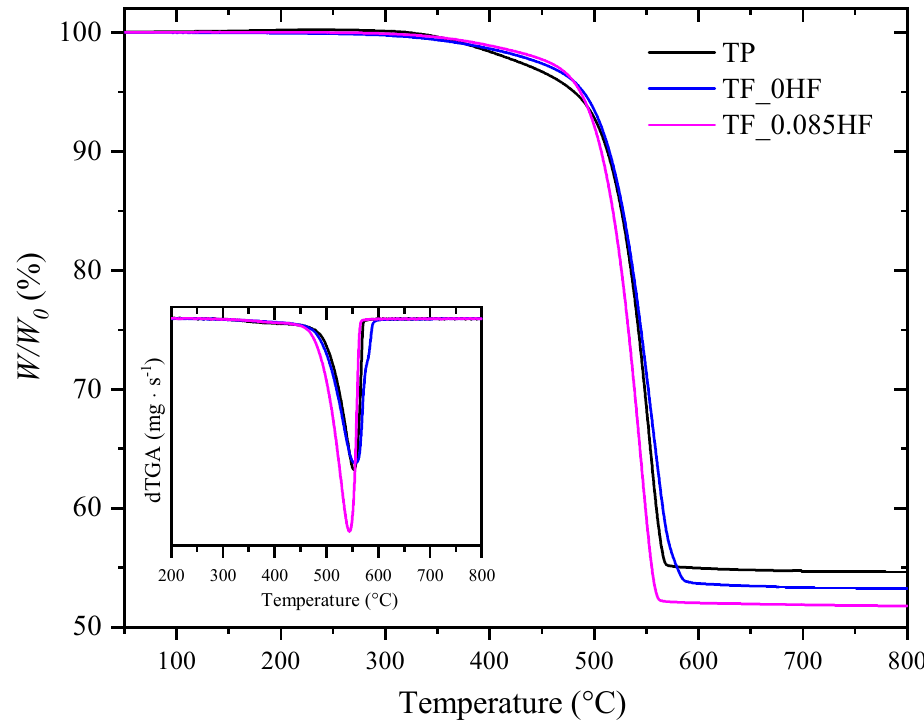
Figure 4. TGA curves of TiOF 2 samples. The inset shows the first derivative dTGA in relation to temperature.